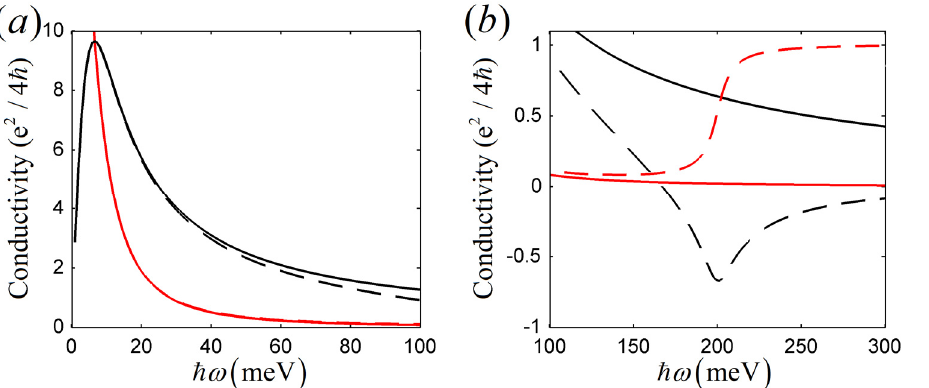
      Figure 2. Optical conductivity of graphene for (a) , and (b) . The solid curves are derived from the Drude model (Equation (7)), and the dashed curves are obtained using the RPA-RT approach (Equation (11)). The real part and the imaginary part of the optical conductivity are plotted in red and black colors, respectively. For both figures, the parameters used are , , and . 300 K T  100 meV    1 10 THz E   F